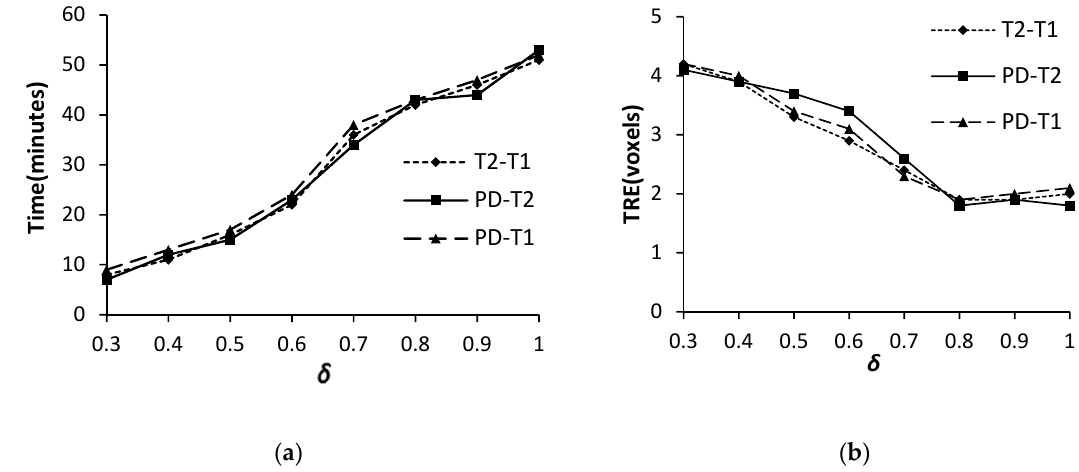
Figure 7. The TRE and computation time with different 𝛿 . ( a ) TRE (voxels); and, ( b ) Time (minutes).